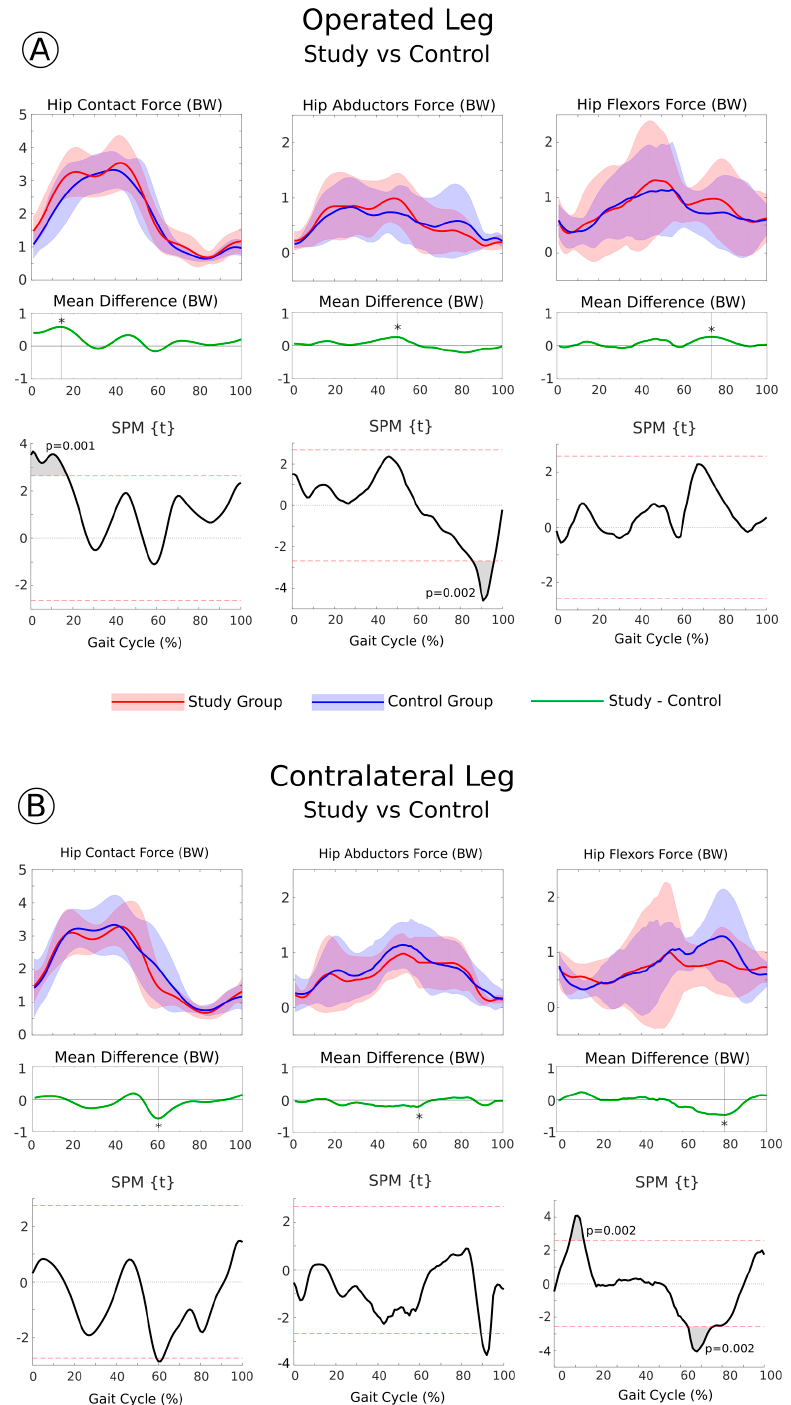
Figure 1. Hip contact forces and muscle forces (normalized to body weight and represented as 1 mean and standard deviation) of the operated leg ( A ) and contralateral leg ( B ) across the gait cycle, compared between the Study Group and the Control Group. The analysis is focused on the hip, including joint contact forces and major muscle forces grouped by function. The asterisk (*) indicates the maximum mean difference. Results from SPM t-tests are reported: when SPM t-values exceed the critical threshold (horizontal dotted lines), the differences between groups are significant, and when significant differences occurred for at least 4% of the gait cycle, the areas are reported in grey with the corresponding p